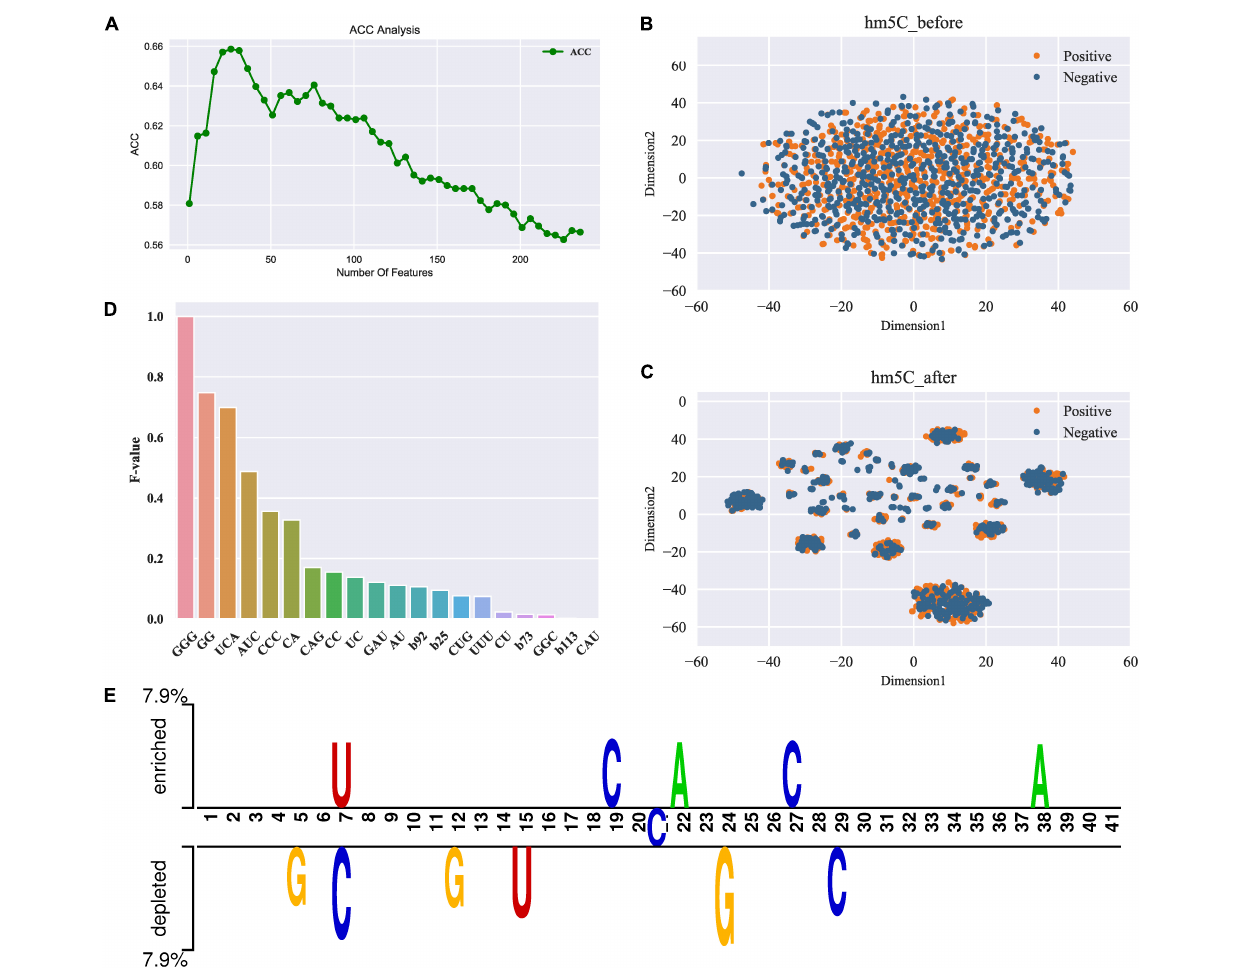
FIGURE 2 | Feature analysis results. (A) ACC curve of the feature selection; (B,C) represent the distribution visualization of the samples (positive and negative) in feature space before and after feature optimization, respectively; (D) F -values of the top 20 most important features. Note that the x -axis represents the specific features and the y -axis represents the F -value. Note that b92 denotes the 92th feature of the binary vector, b25 denotes the 25th feature, and so forth; (E) TSL (Two Sample Logos) visualization of the positives and negatives in the dataset used in this study.